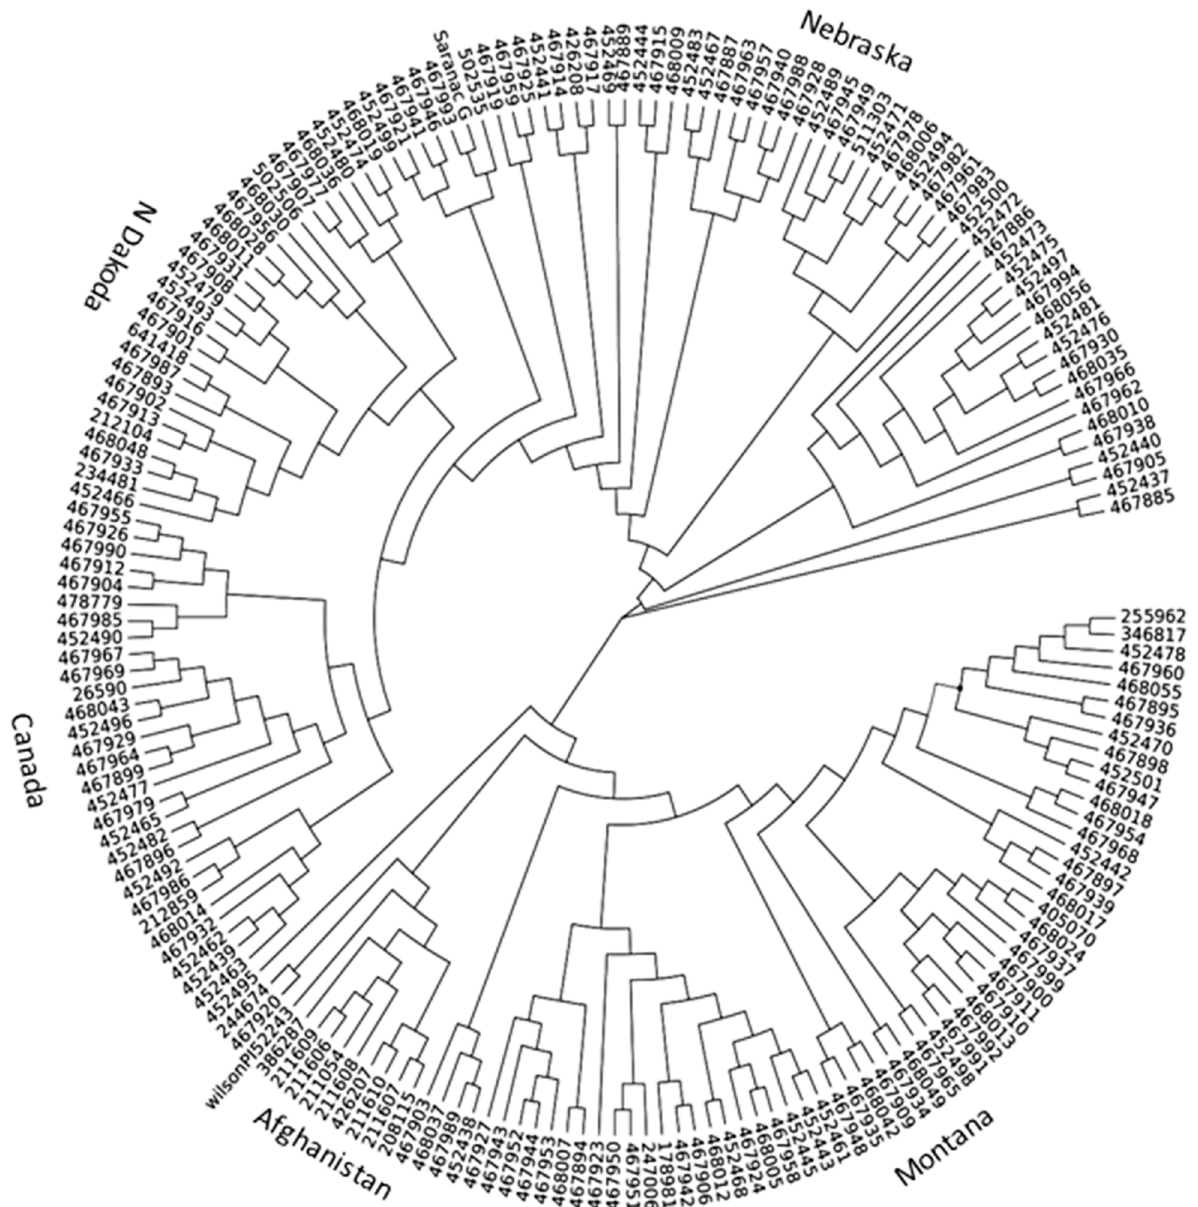
Fig 1. Phylogenic analysis of 198 alfalfa accessions using the marker data generated by GBS and neighbor-joint tree. Their origins are indicated outside of the phylogenic